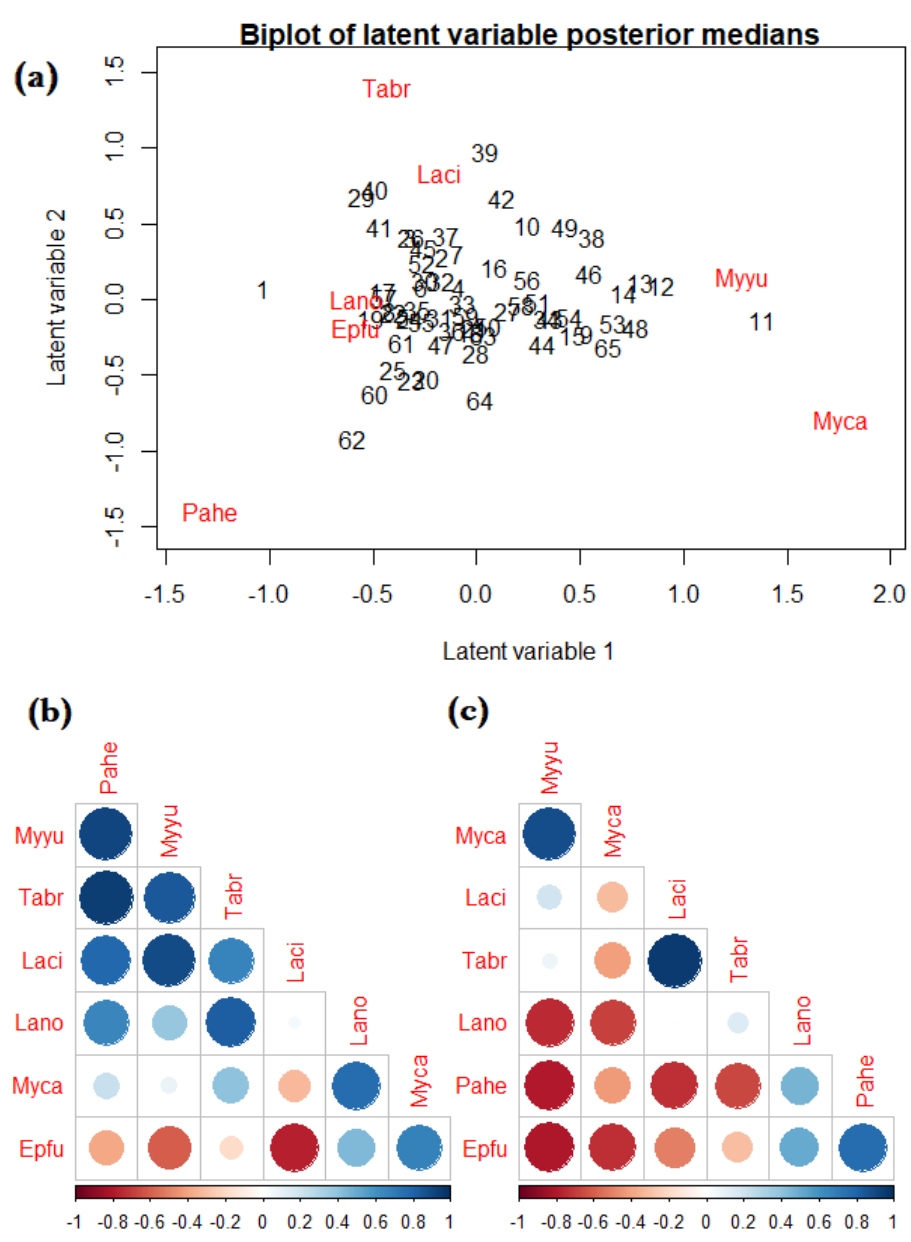
Figure 4. ( a ) A residual ordination biplot based on latent variable posterior medians; ( b ) a plot of the between-species correlation arising from shared environmental responses; and ( c ) a plot pf correlations between species due to residual correlations when fitting an NB joint species distribution to the bat acoustic data. The 20 site numbers are labeled in black, and the seven bat species are shown in red and labelled by the following abbreviated names: Tadarida brasiliensis (Tabr), Eptesicus fuscus (Epfu), Lasionycteris noctivagans (Lano), Lasiurus cinereus (Laci), Parastrellus hesperus (Pahe), Myotis yumanensis (Myyu), and Myotis californicus